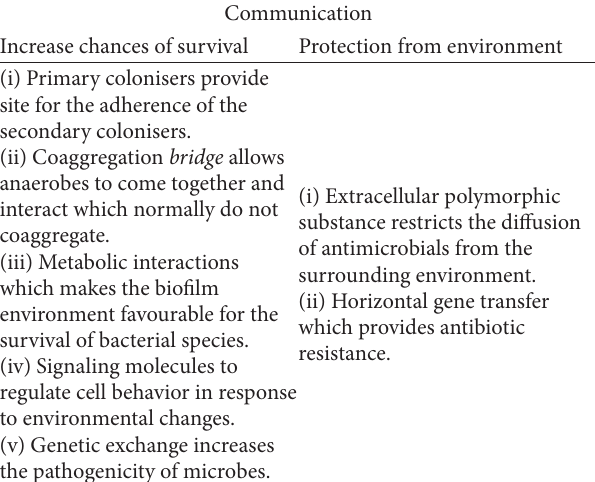
Table 1: Describing the various benefits of interspecies communi- cations in